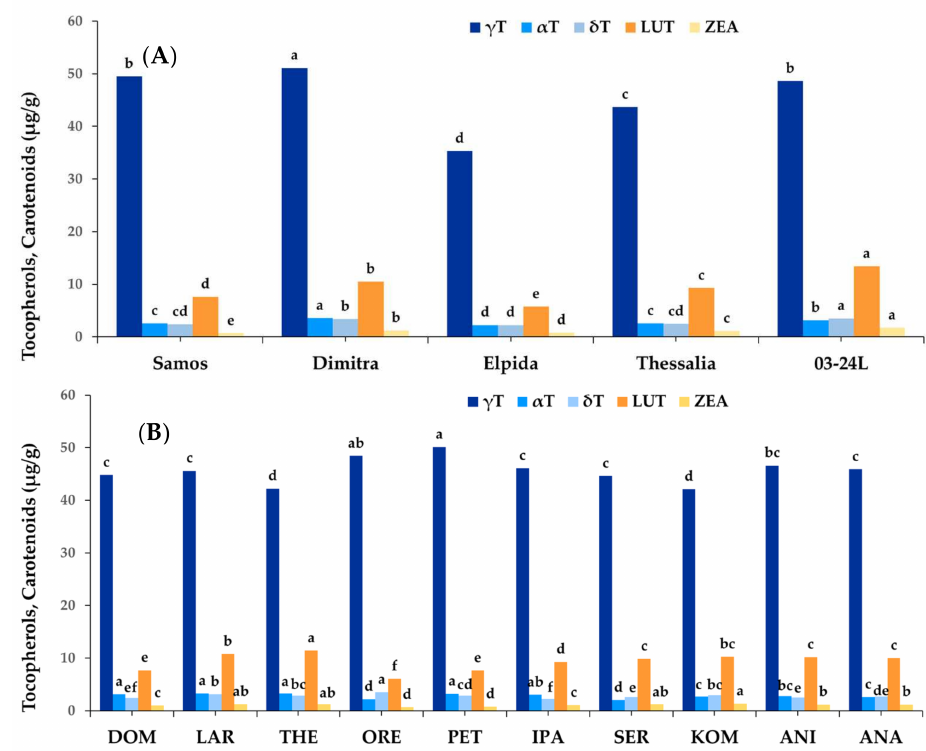
Figure 2. Quantification of tocopherols and carotenoids in lentil seeds for ( A ) genotypes (Samos, Dimitra, Elpida, Thessalia and 03-24L) and ( B ) locations (DOM, Domokos; LAR, Larissa; THE, Thessaloniki; ORE, Orestiada; PET, Petrana; IPA, Ipato; SER, Serres; KOM, Komotini; ANI, Agioi Anargiri; ANA, Anatoliko) tested. ( α T, α -tocopherol; γ T, γ -tocopherol; δ T, δ -tocopherol; LUT, lutein; ZEA, zeaxanthin). Bars followed by the same letter in the same assay are not significantly different ( p ≤